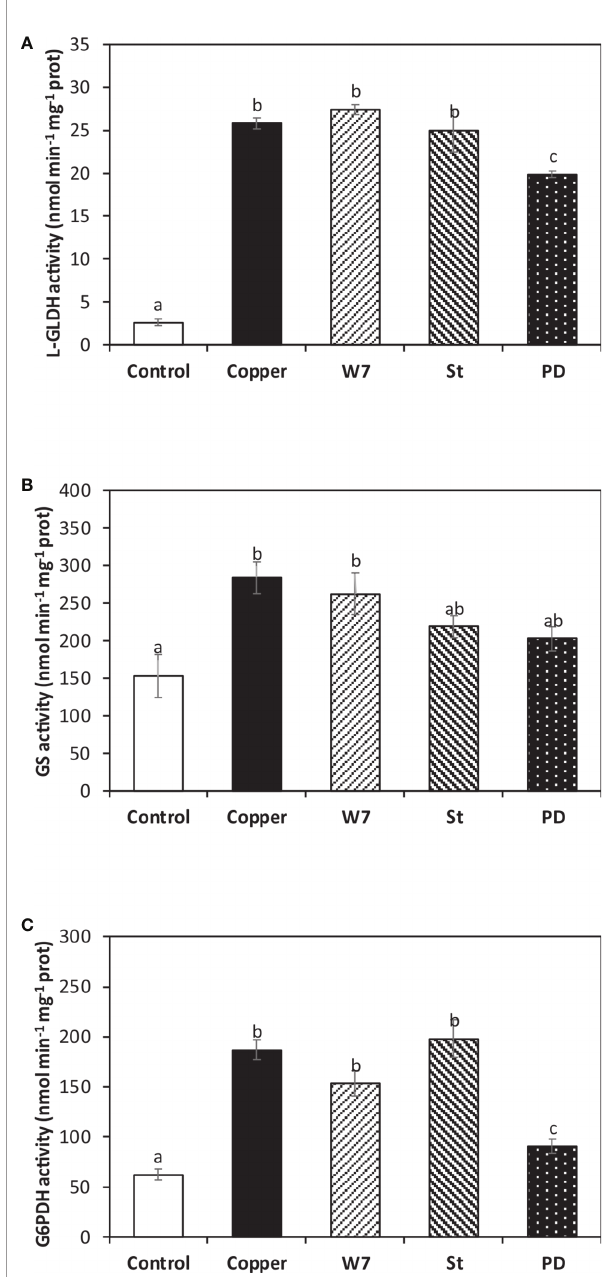
FIGURE 4 | Activities L-galactono 1,4 lactone dehydrogenase (L-GLDH, A ), glutathione synthase (GS, B ) and glucose 6-P dehydrogenase (G6PDH, C ) cultivated in seawater without copper addition for 5 days (open bars), with 10 µM of copper and with 100 µM of W-7, 10 µM staurosporine (St), 5 µM of PD-98059 (PD) and 10 µM copper for 5 days (hashed bars). Enzyme activities are expressed in nanomoles per minute per milligram of protein extract. Bars represent mean values of three independent experimets. Different letters indicate signi fi cant diferences among mean values (±SD) ( P <